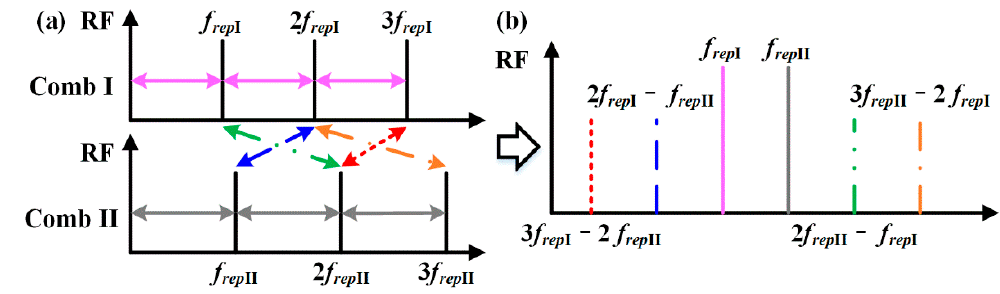
Figure 4. The schematic of RF spectrum generation for dual-combs I and II from sub-ring 1. ( a ) The individual RF spectrum of combs I and II. ( b ) The final RF spectrum output from sub-ring 1.